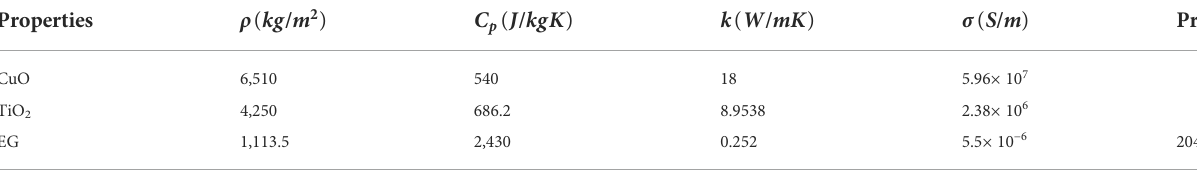
TABLE 1 Thermophysical properties of nanoparticles and base liquid Khan et al. (2022). Properties